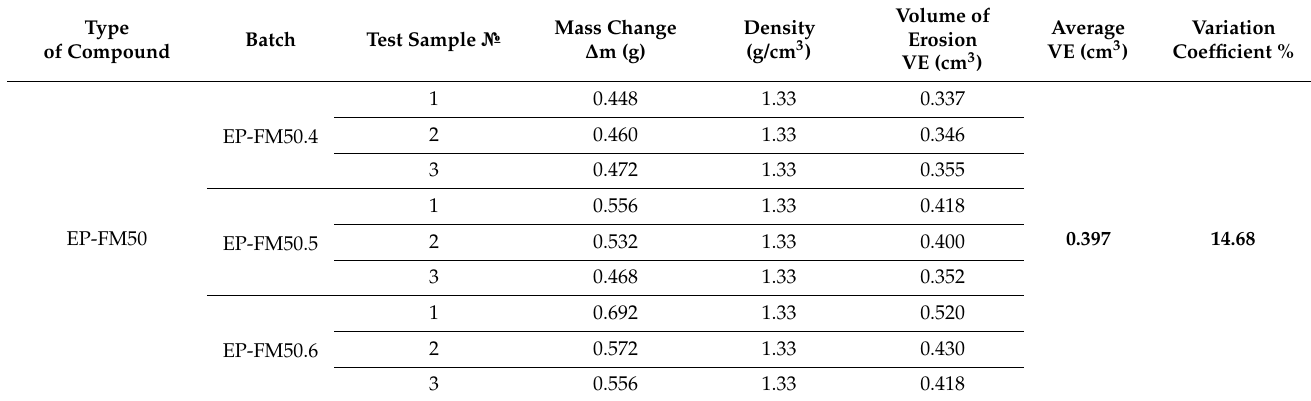
Table A22. Wear of filled epoxy binder (EP-FM50) at 100 ◦ C at an impingement angle of 45 ◦ .